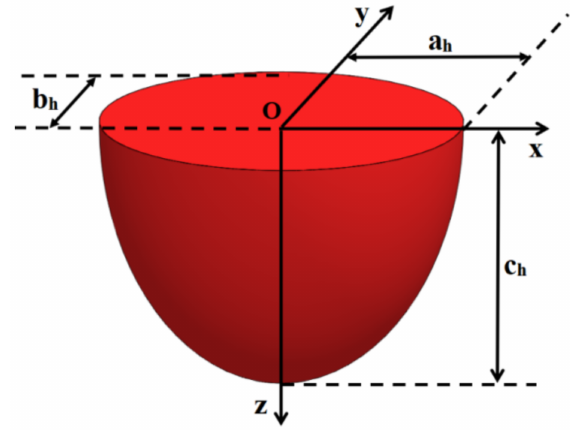
Figure 3. Semi-ellipsoid heat source model.